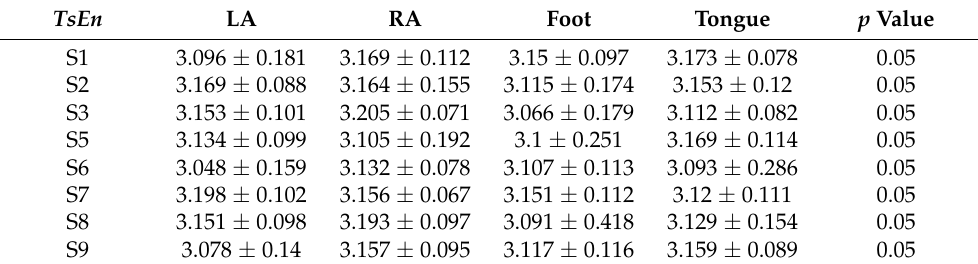
Table 5. The average values (mean ± SD) of TsEn to estimate the MI-BCI performance from four classes (left hand, right hand, feet, and tongue) of eight subjects individually. TsEn LA